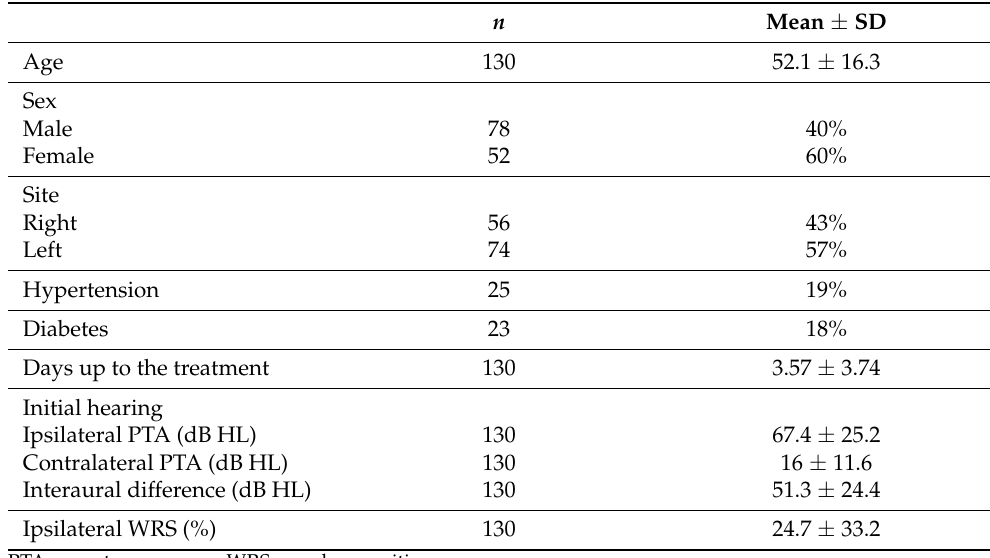
Table 2. Patient demographics and audiologic data during the diagnosis of idiopathic sudden sensorineural hearing loss.